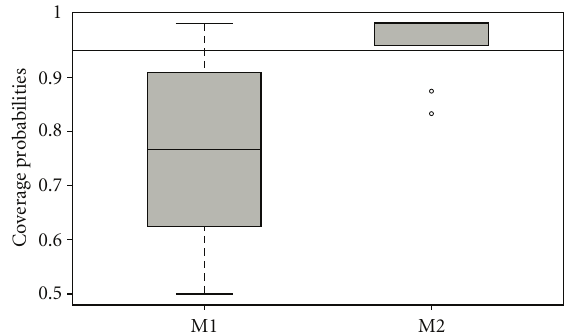
Figure 6: Boxplots of the coverage probabilities using M1 and M2 at the 95% nominal